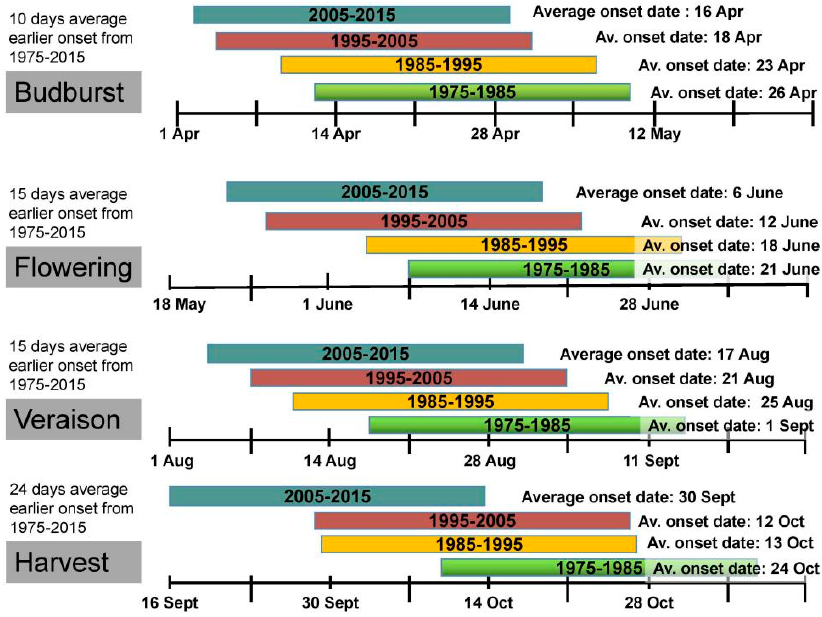
Figure 1. Phenological shifts based on average onset dates for bud break, flowering, veraison and harvest of four grapevine varieties (“Pinot Gris”, “Pinot Noir”, “Riesling” and “Muller Thurgau”) grown in Hainfeld (Southwest Germany) from 1975 to 2015. Based on data from a previously published study [18].